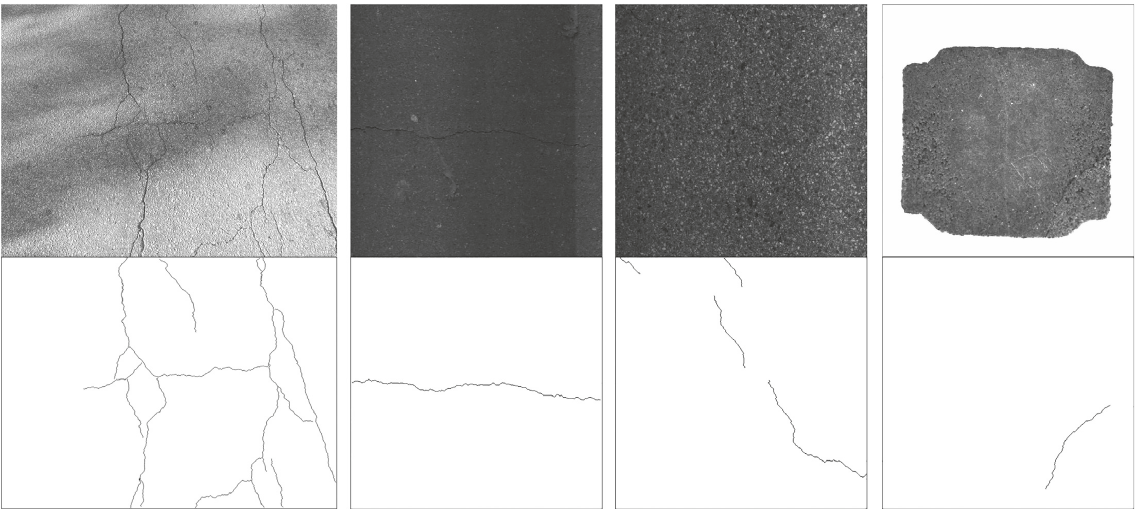
Figure 2: Examples of crack images (top row) and ground-truth images (bottom row) as provided by DeepCrack [28]. Columns from left to right are the datasets named CrackTree260, CRKWH100, CrackLS315, and Stone331, respectively. Note that images in the bottom row are inverted here for clear visualization.